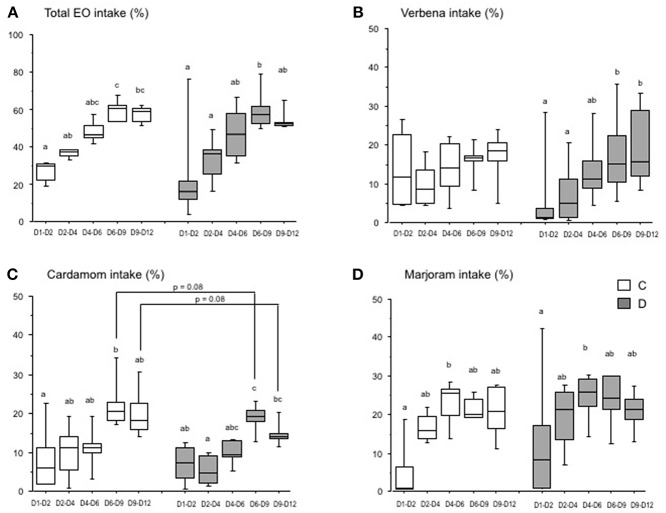
Essential oil intake by chicks over time (Experiment 2). Chicks were either directly placed in pens (C group, white) or delayed for 24 h (D group; gray). The histograms show the box-plots and whiskers of EO intake (EO/(water + EO), %) for each group, and the three EO (A), verbena (B), cardamom (C), and marjoram (D). Different letters indicate significant differences between periods for each group of chicks (Dunn test). The p-values indicate significant differences between the C and D groups within each period (Mann-Whitney test).